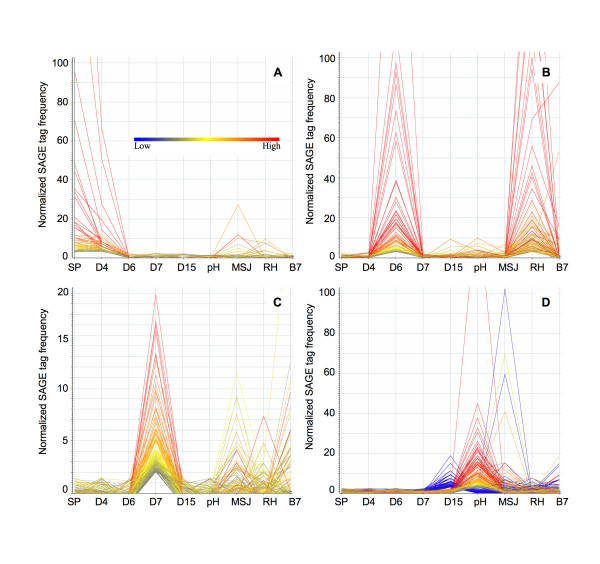
Groups of co-regulated mRNAs are associated with the major developmental transitions. Stage-specific gene expression as defined by normalized fold-change within the six developmental libraries was determined without regard to the level of expression in the laboratory-adapted strain libraries. SAGE tag clusters for the combined sporozoite and Day-4 post-sporozoite infection, Day-6, Day-7 and Day-15/pH-shifted and their respective plots were generated using GeneSpring 7.2 software. Similar distributions were obtained using standard k-means clustering (not shown). Note that expression of each SAGE tag within the four co-regulated sets was plotted for all nine libraries including the laboratory strains with expression color-coded by the level in the relevant developmental libraries. [A] Parasites emerging from sporozoite-infections at Day-4 post inoculation possessed high levels of sporozoite-specific gene expression (0.728 correlation between these libraries) that were nearly all down-regulated by Day-6 post-sporozoite infection and beyond. Note that with the exception of a few SAGE tags in the Type III (VEGmsj) library there is little expression of these genes in the laboratory strains. [B] Genes specifically expressed >3-fold in Day-6 post-sporozoite SAGE libraries (120 total) were also uniquely elevated in the Type I-RH library suggesting these parasites have a common gene expression that may reflect shared biology. Note that the expression of these genes is largely exclusive to RH and Day-6 and that the levels of expression are remarkably similar in each library. [C] Parasites post-growth shift at Day-7 (15 h doubling) represent a developmentally unique stage positioned at the initiation of bradyzoite development. Fully 5% of the total SAGE tags expressed in this stage showed regulation (15 % difference between Day-7 and Day-6) with relatively few known bradyzoite-specific genes expressed at this stage. Note that there was considerable shared expression of Day-7 SAGE tags with the laboratory strains, although expression levels showed higher or lower expression in lab strains as reflected in the color scale of individual curves that were fixed by the Day-7 levels in this gene plot. [D] Based on SAGE tag frequencies, 698 genes were found to be expressed >3-fold higher in the Day-15/pH-shift libraries. Genes identified in this set included the known bradyzoite genes BAG1, LDH2, SAG4.2, enolase 1, cyst-wall protein and a novel bradyzoite-specific NTPase. A number of the SAGE tags contained in this cluster were also elevated in the laboratory strains VEGmsj and Me49B7, while the RH strain showed little or no expression of the tags from this gene set as was found for the other developmental libraries including Day-6.